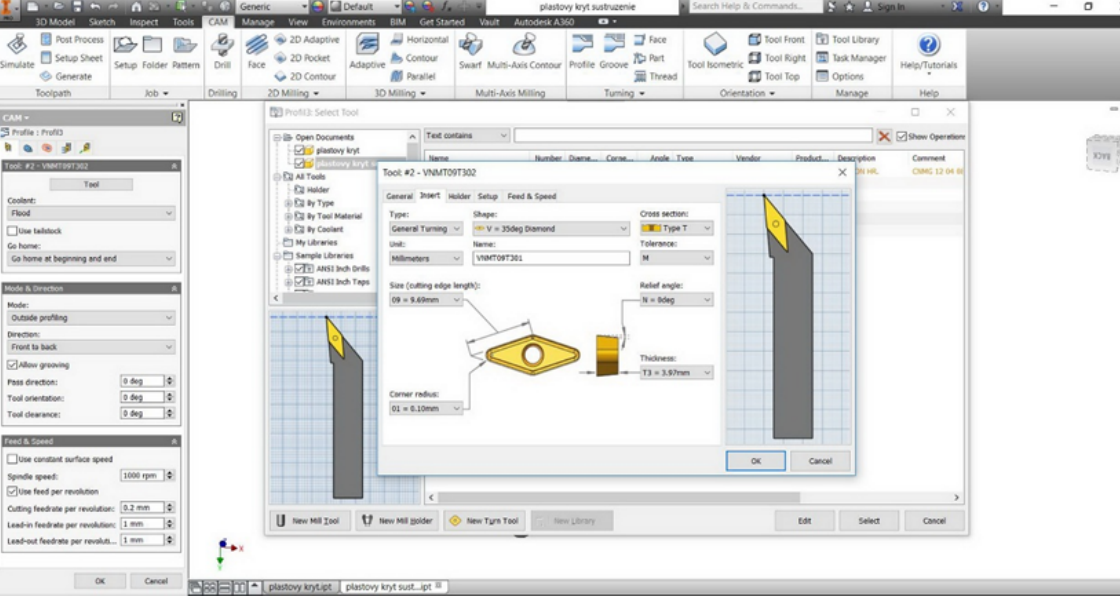
The flange material is Polyamide PA6. It is used to cover the end arm of the robot while supporting the end and reference position sensors. The spherical surface serves to guide and centre the sensor holder during the po- sitioning of the robot arms. For the production of a diame- ter of 126 mm, a tolerance of ± 0.04 mm and a deviation of circularity of 0.05 mm should be observed. Required sur- face roughness is Ra =